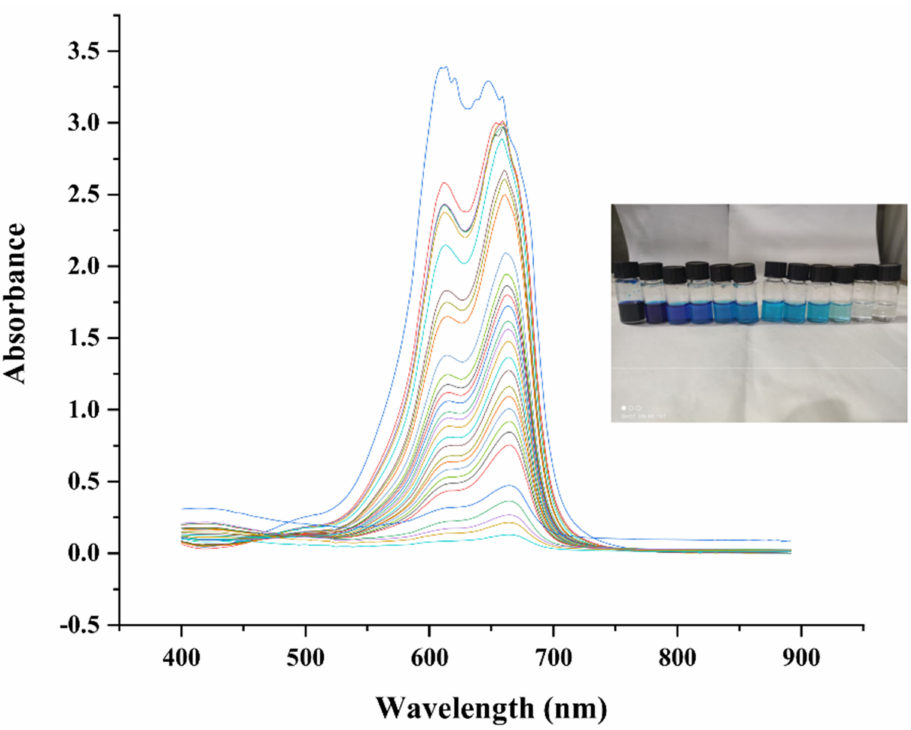
Figure 11. UV-vis spectrum recorded after treating solution of methylene blue with NaBH 4 and synthesized silver nanoparticles (taken after each 2 min for an hour).